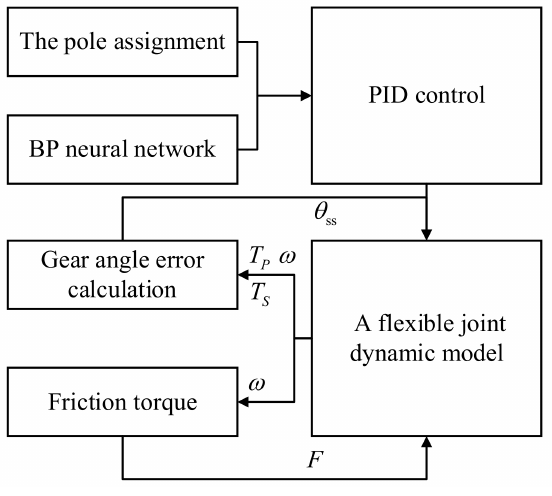
Figure 2. Schematic diagram of flexible joint with gears. T represents the driving torque, m a represents the load end angle, F represents the friction torque, s l J torsional stiffness, m represents the moment of inertia at the motor end, and l sents the moment of inertia at the load end.